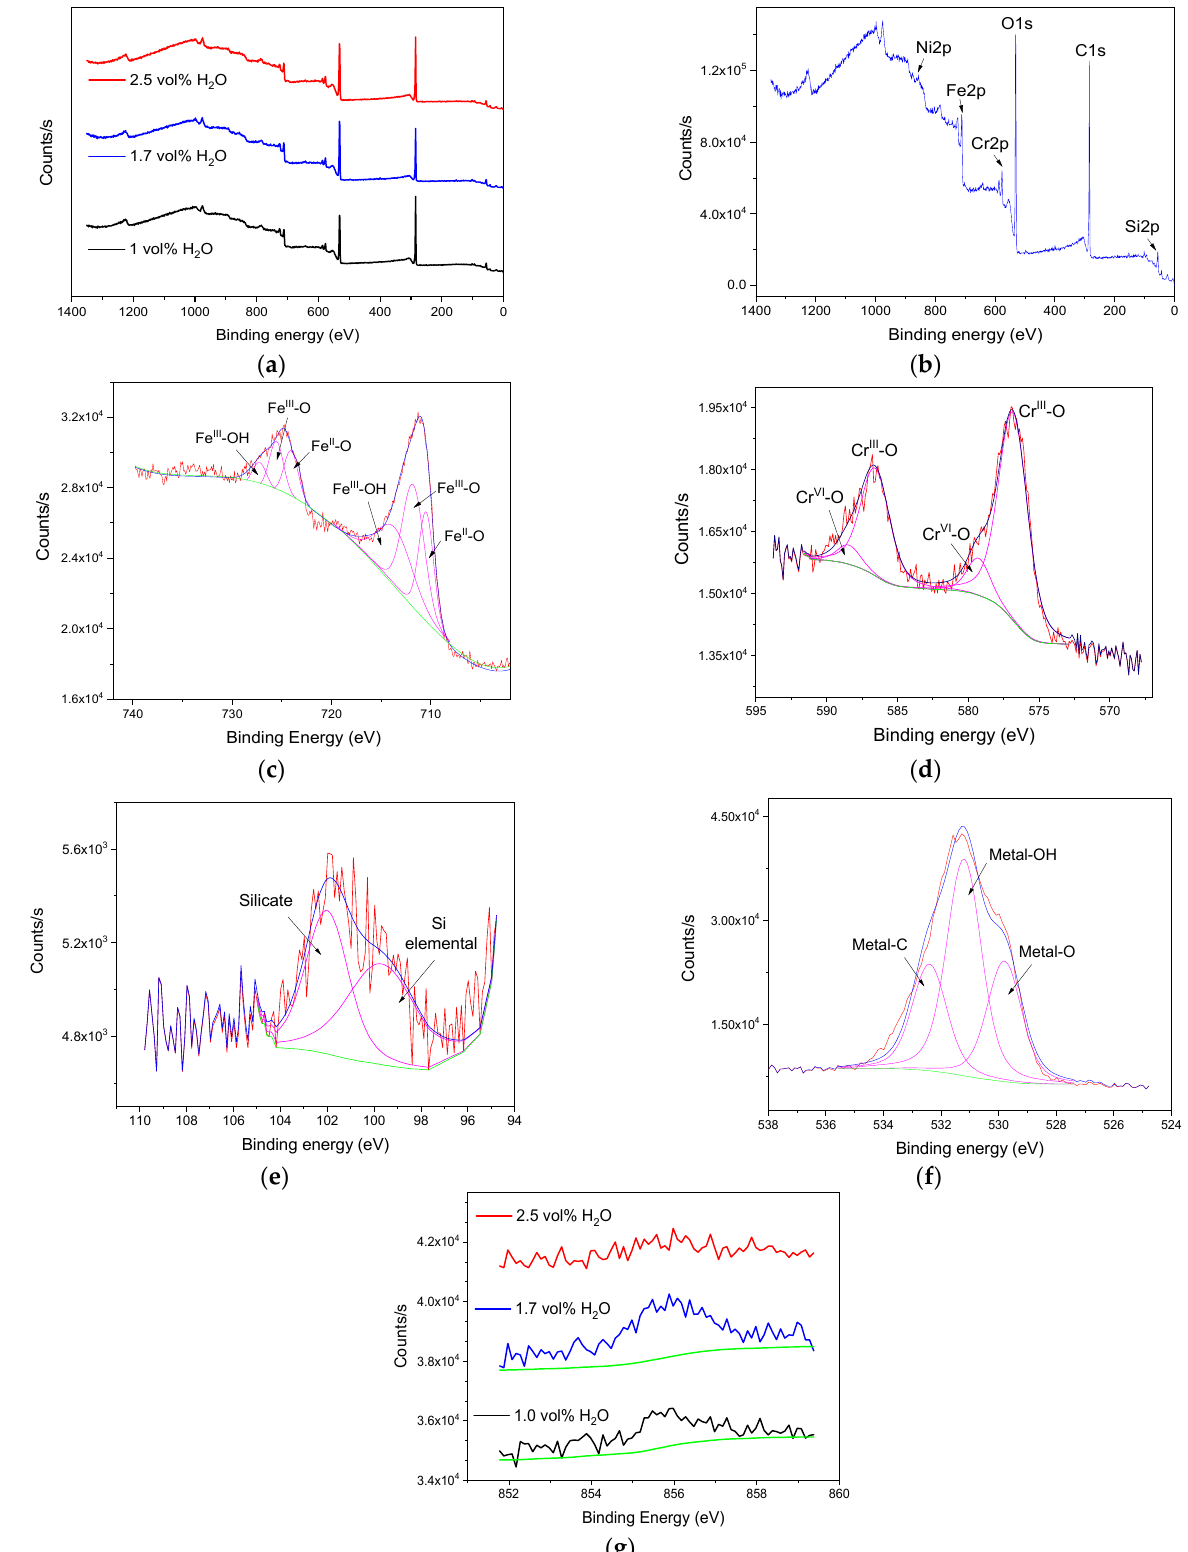
Figure 10. XPS spectra of the anodic layers grown in glycerol, 0.05 M Na 2 SiO 3 with H 2 O concentration ( a ) from 1.0 to 2.5 vol%, and ( b ) 1.7 vol% for 6 min at 20 mA/cm 2 . Deconvolutions plots of the ( c ) Fe2p, ( d ) Cr2p, ( e ) Si2p, ( f ) O1s, and ( g ) Ni2p scan of the anodic layers grown in glycerol, 0.05 M Na 2 SiO 3 and 1.7 vol% H 2 O.